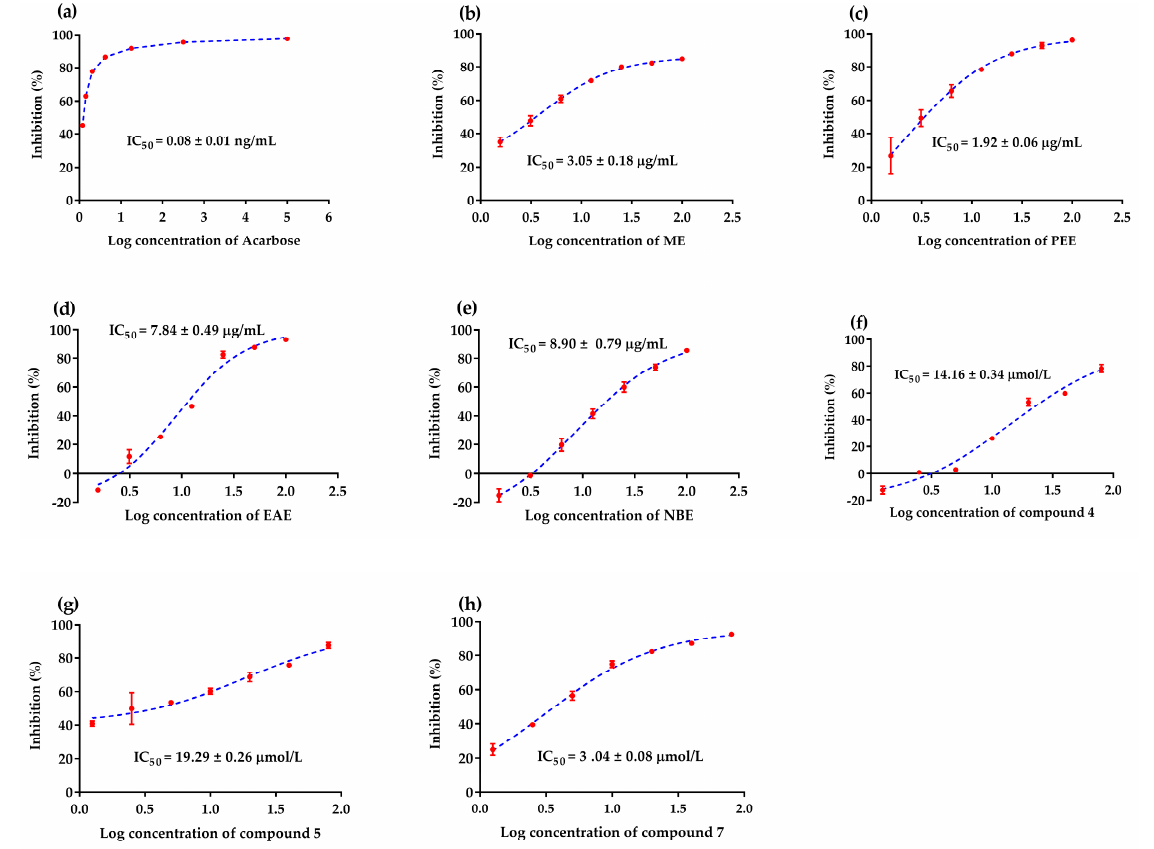
Figure 7. α -Glucosidase inhibitory effects of T. grandis methanolic extract, fractions and compounds 4 , 5 and 7 . ( a ) Log concentration–inhibition rate fitting curve of acarbose. ( b ) Log concentration– inhibition rate fitting curve of ME. ( c ) Log concentration–inhibition rate fitting curve of PEE. ( d ) Log concentration–inhibition rate fitting curve of EAE. ( e ) Log concentration–inhibition rate fitting curve of NBE. ( f ) Log concentration–inhibition rate fitting curve of compound 4 . ( g ) Log concentration– inhibition rate fitting curve of compound 5 . ( h ) Log concentration–inhibition rate fitting curve of compound 7 . All values are mean ± SD from three independent experiments. ME: methanolic extract, PEE: petroleum ether extract, EAE: EtOAc extract and NBE: n-BuOH extract.